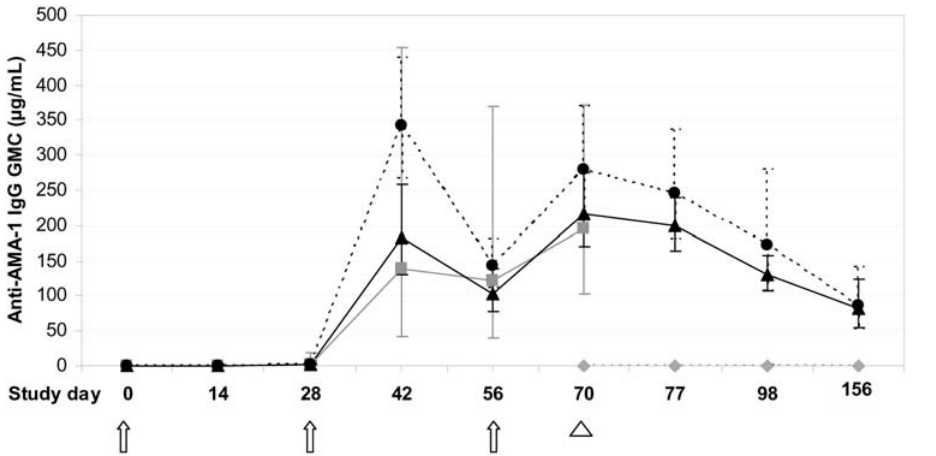
Figure 2. Geometric mean concentration (GMC) of anti-AMA-1 antibody by ELISA. Arrows indicate immunization time points and arrowhead indicates day of malaria challenge. Gray solid line with & symbol: GMCs for low dose AMA-1/AS01B vaccinees; black solid line with m symbol: GMCs for high dose AMA-1/AS02A vaccinees; small black dashed line with $ symbol: GMCs for high AMA-1/AS01B vaccinee;, small dashed gray line with ¤ symbol: GMCs for infectivity controls. 95% CIs are shown for each time point.